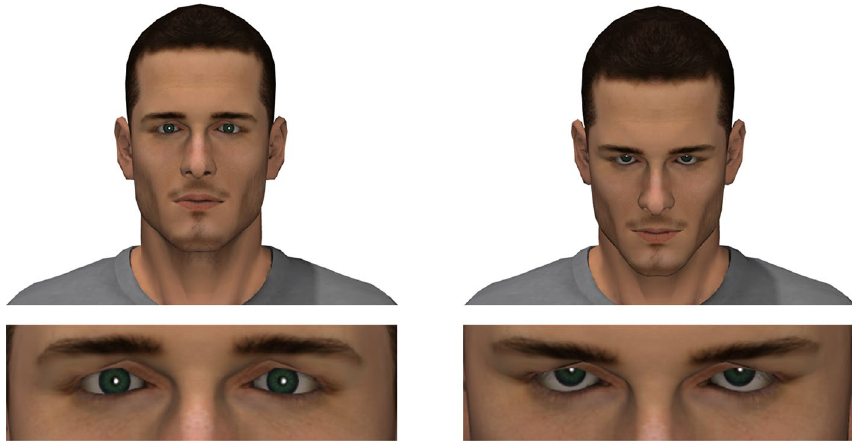
Figure 1. Neutral head angle (left) and downward-head tilt (right) stimuli, with the whole head visible (top), and the upper face visible with the rest of the face and head occluded (bottom). Stimuli were generated using Smith Micro 32 Poser Pro computer